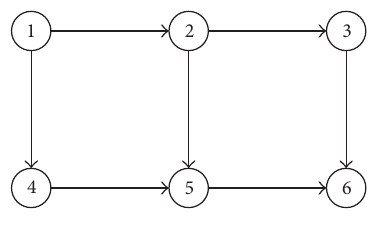
Figure 1: A simple